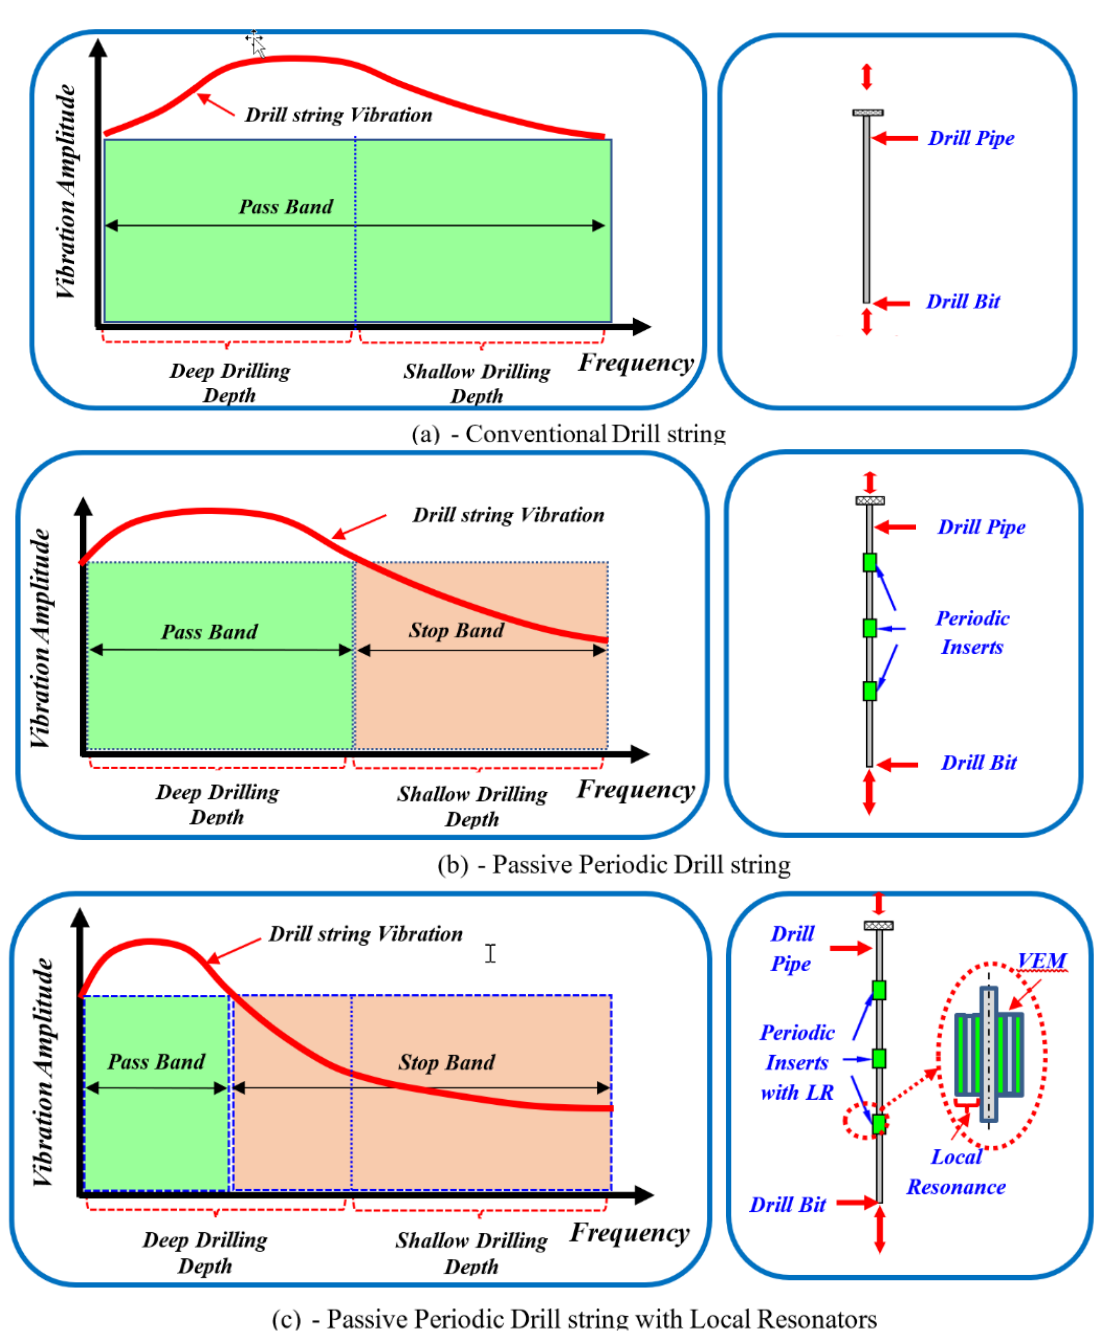
Figure 3. Vibration mitigation characteristics of conventional and periodic drill-string. ( a ) conventional drill string; ( b ) passive periodic drill string; ( c ) passive periodic drill string with local resonators.